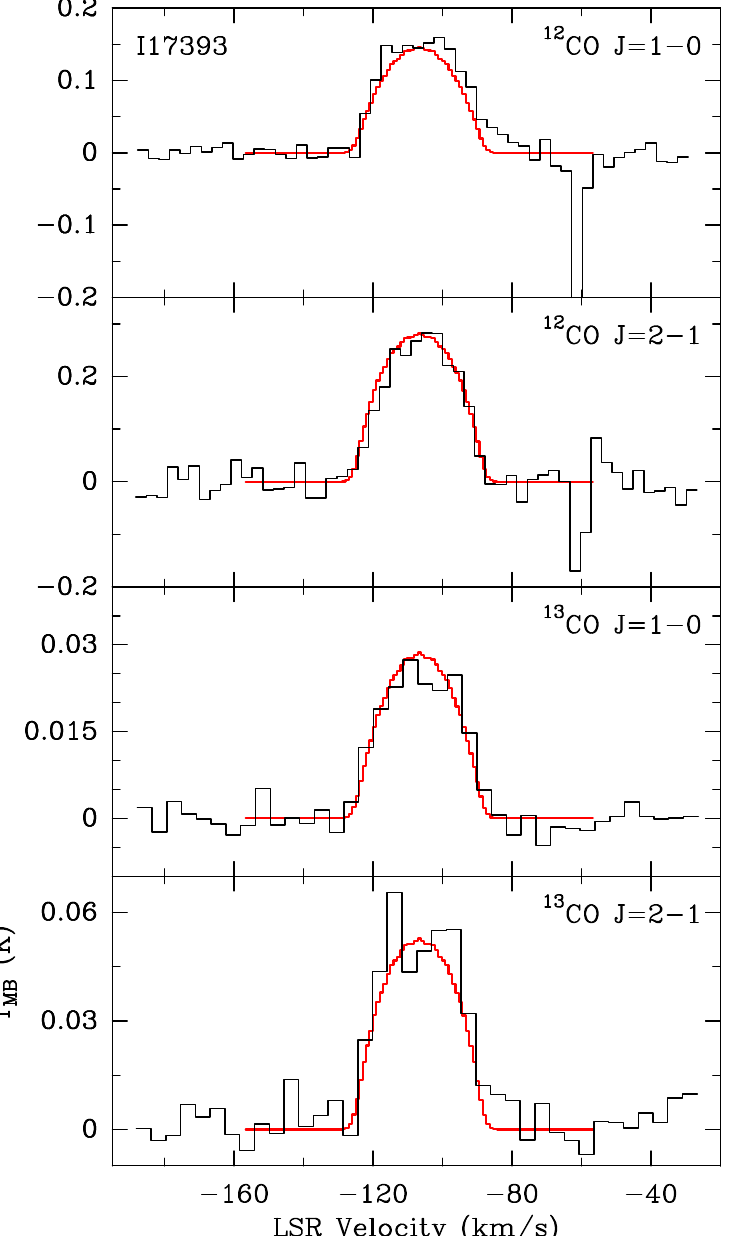
Figure 1. Synthetic spectra (red) and observations (black) for 12 CO and 13 CO transitions detected in IRAS 17393 − 2727 with the IRAM 30 m telescope. The (shortened) source name is indicated at the top of the first panel. Note the different intensity ranges in the panels. All the spectra span 175 km s − 1 of coverage. The original spectra have been smoothed at a velocity resolution of 3 km s − 1